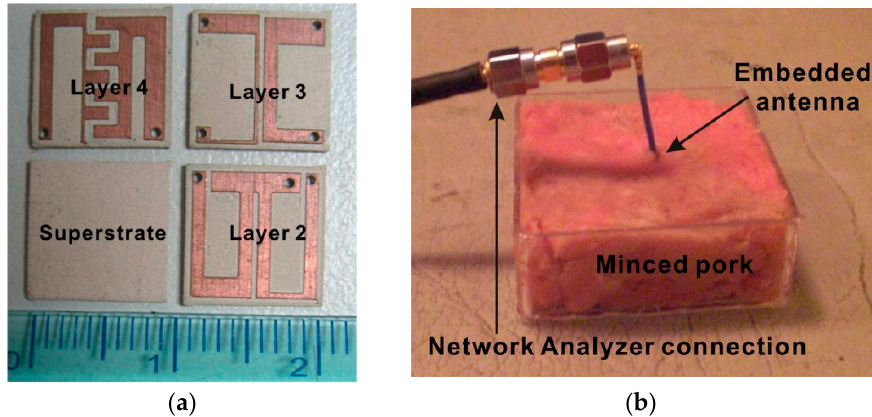
Figure 38. RFF WPT antenna [183]. ( a ) Fabricated triple-band miniaturized antenna. ( b ) Measurement setup embedded in minced pork. Copyright © 2011, IEEE.